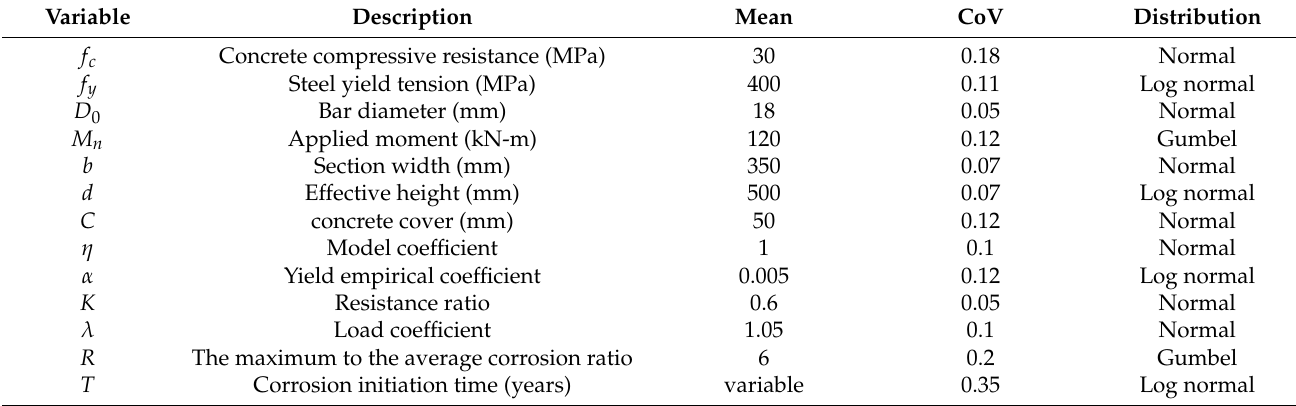
Table 1. Descriptive statistical properties of the basic random variables of the reinforced concrete beam.